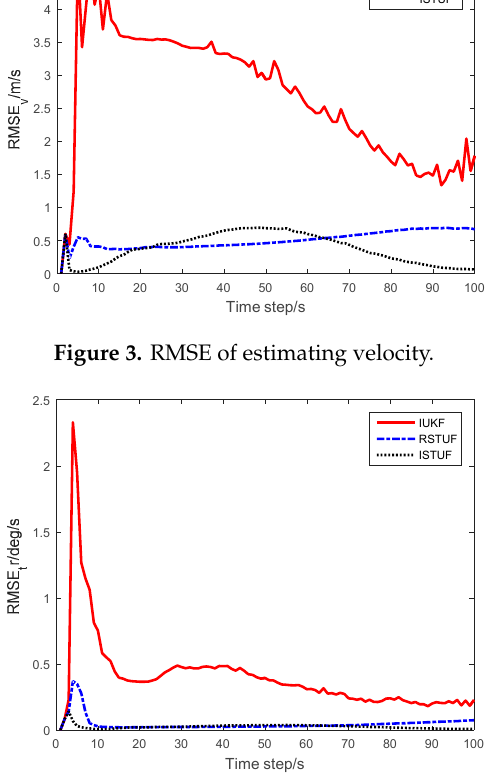
Figure 4. RMSE of estimating turn rate.